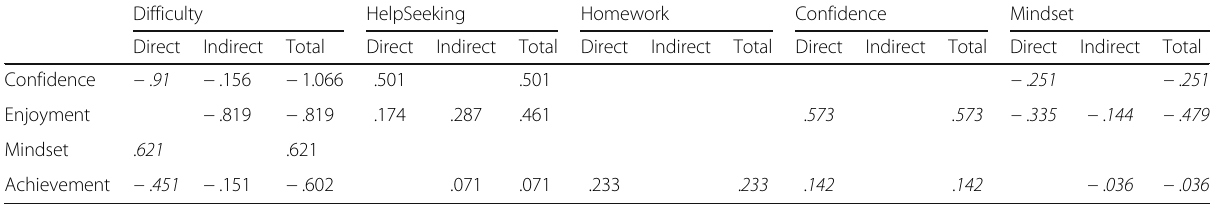
Table 4 Summary of latent variable